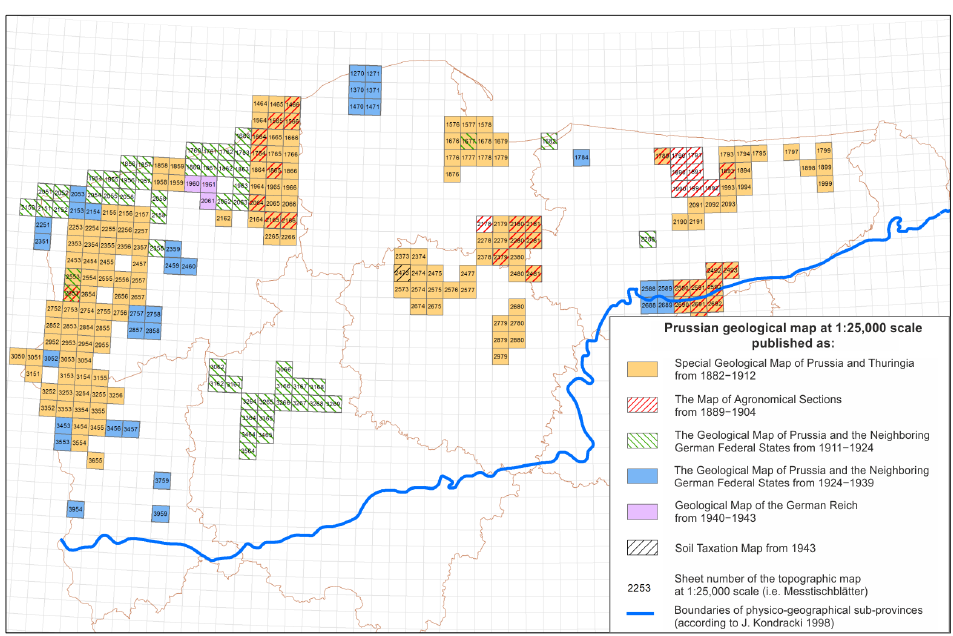
Fig. 2. Section map and age structure of the Prussian geological map at the scale of 1:25,000 of the area of Northern Poland from the collection of MGB and PB